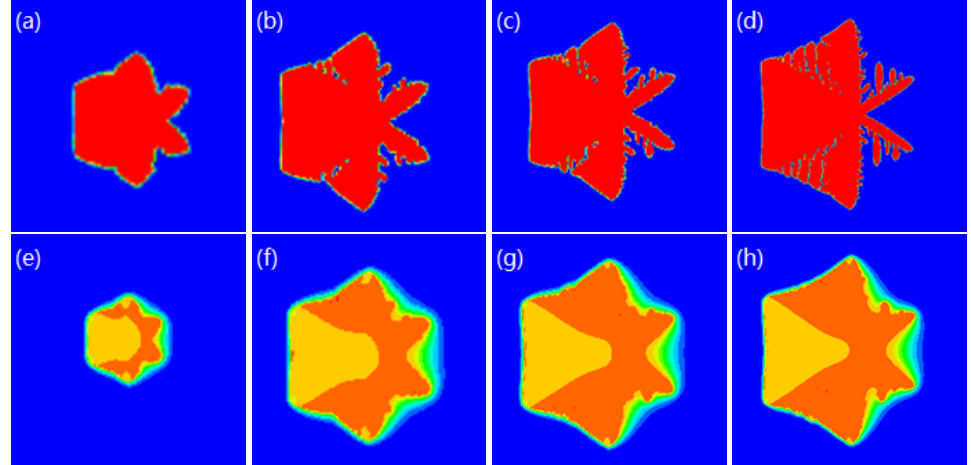
Figure 9. When K 0 = 1.25, v x = 0, and v y = 1.5, the simulated morphology of dendrites and the corresponding temperature field distribution affected by the flow velocity. (( a – d ) is the crystalline morphology of the polymer after adding the flow rate and ( e – h ) is its corresponding tempera- ture